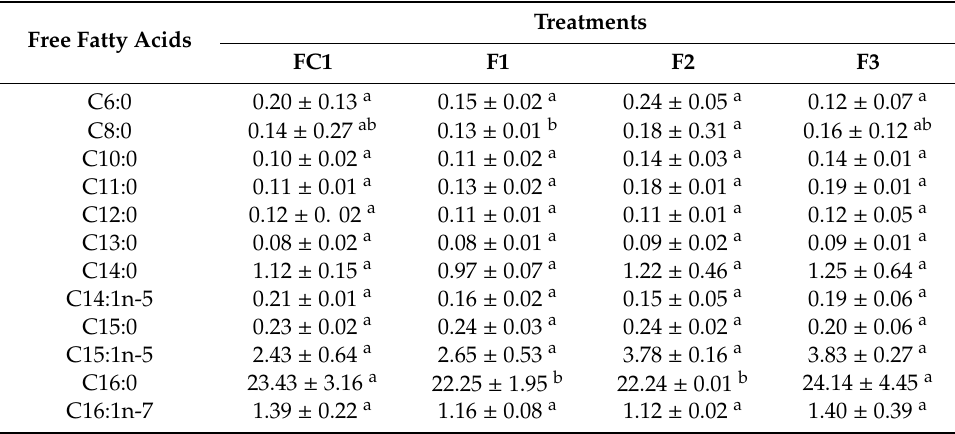
Figure 4. Graphic representation of the volatile compounds expressed as AU × 10 4 / g. ( a ) % of total volatile compounds, ( b ) from each chemical family detected on salted meat. FC1: 100% NaCl; F1: 50% NaCl + 50% KCl; F2: 50% NaCl + 50% CaCl 2 ; F3: 50% NaCl + 25% KCl + 25% CaCl 2. Table 5. Free fatty acids (%) of salted meat (0 day of